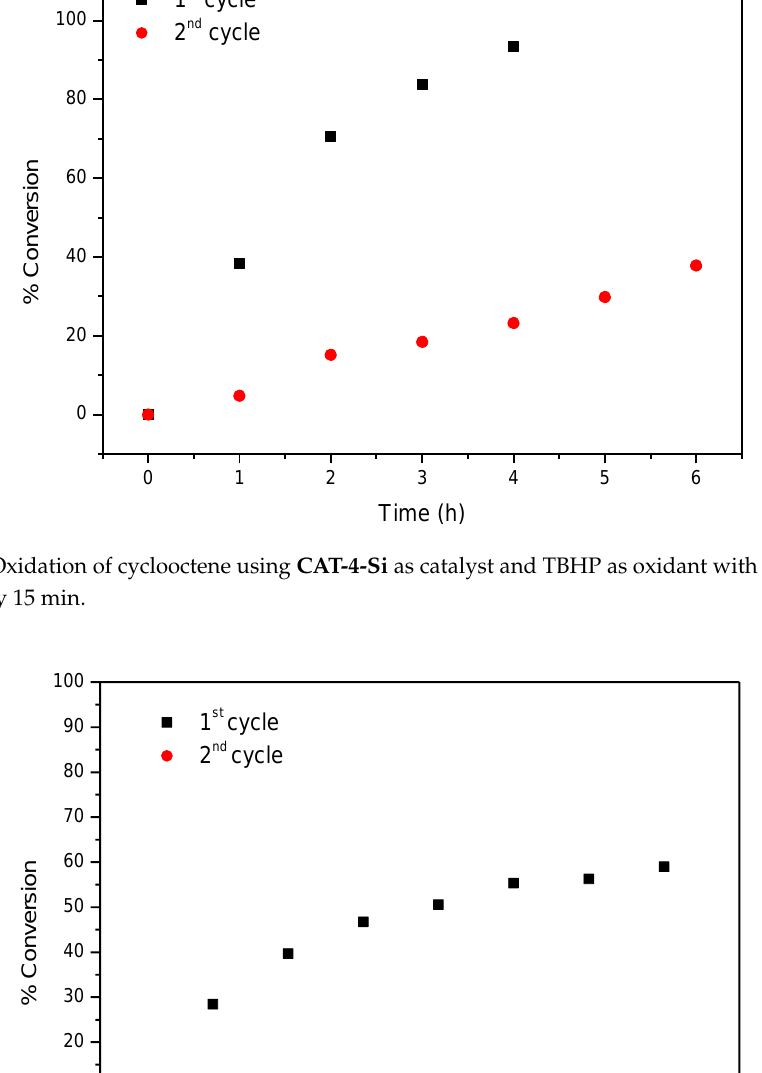
Figure 11. Oxidation of cyclooctene using CAT-4-Si as catalyst and diluted (1:5) H 2 O 2 as oxidant with additions of 0.5 eq. every 15 min.